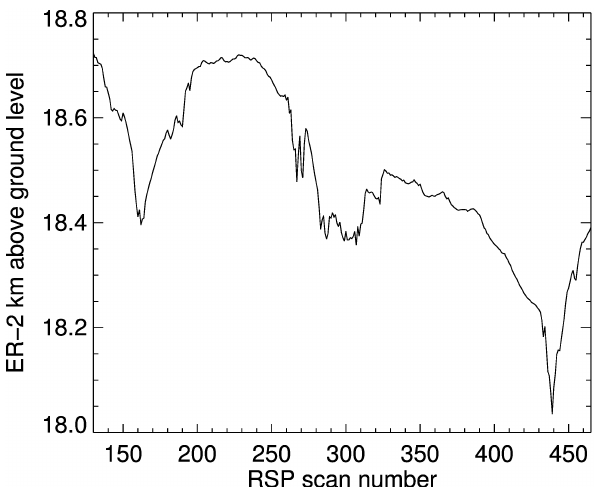
Figure 3. Although the ER-2 holds absolute altitude within tens of meters, the size of the RSP footprint will depend on the sensor’s height above ground level, which varies by almost a kilometer in the data set used